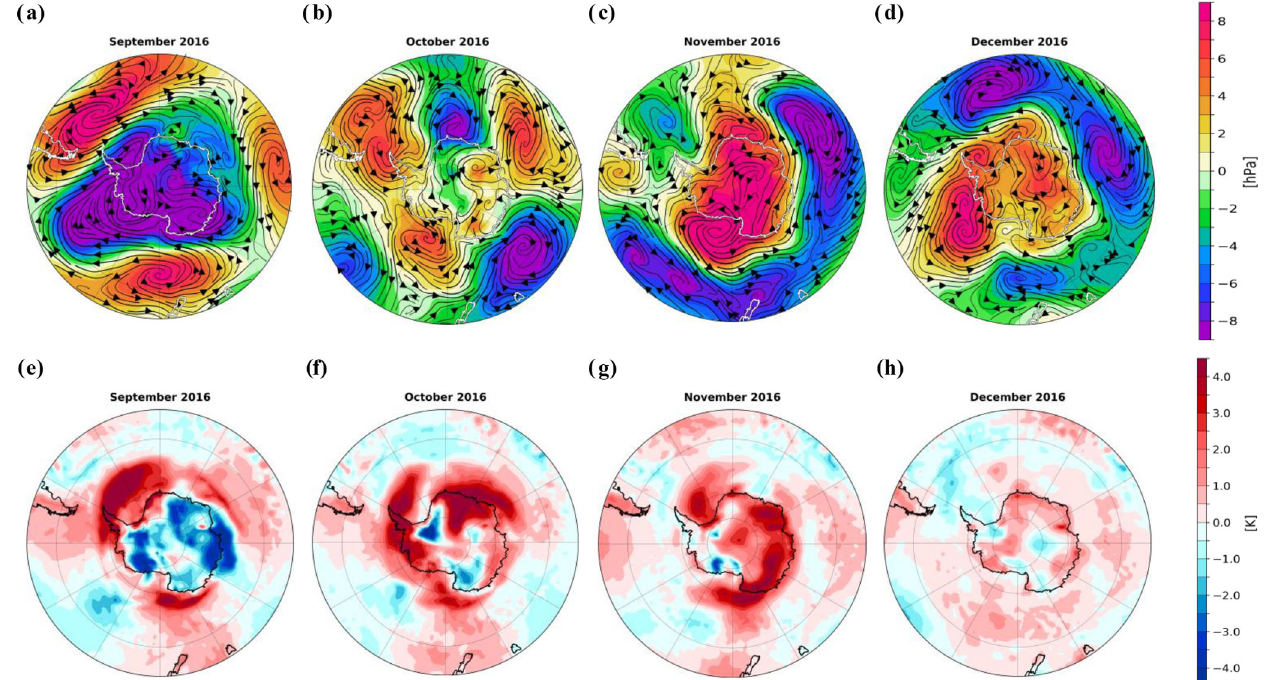
Figure 2. Sea level pressure (SLP) anomalies and the associated wind streamlines (a–d) and 2m air temperature (T2m) anomalies (e–h) from September until December 2016. The anomalies are computed relative to the reference period